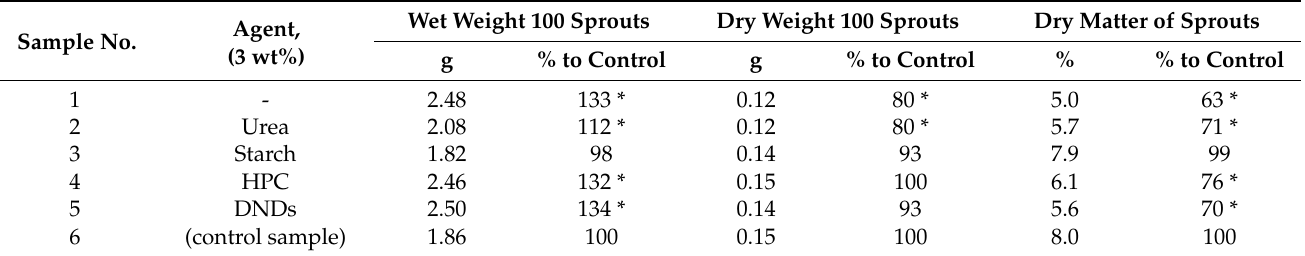
Table 3. Influence of adding hydrogel to the root environment on the accumulation of raw, dry weight and dry matter by Lepidium sativum L. variety Ajur